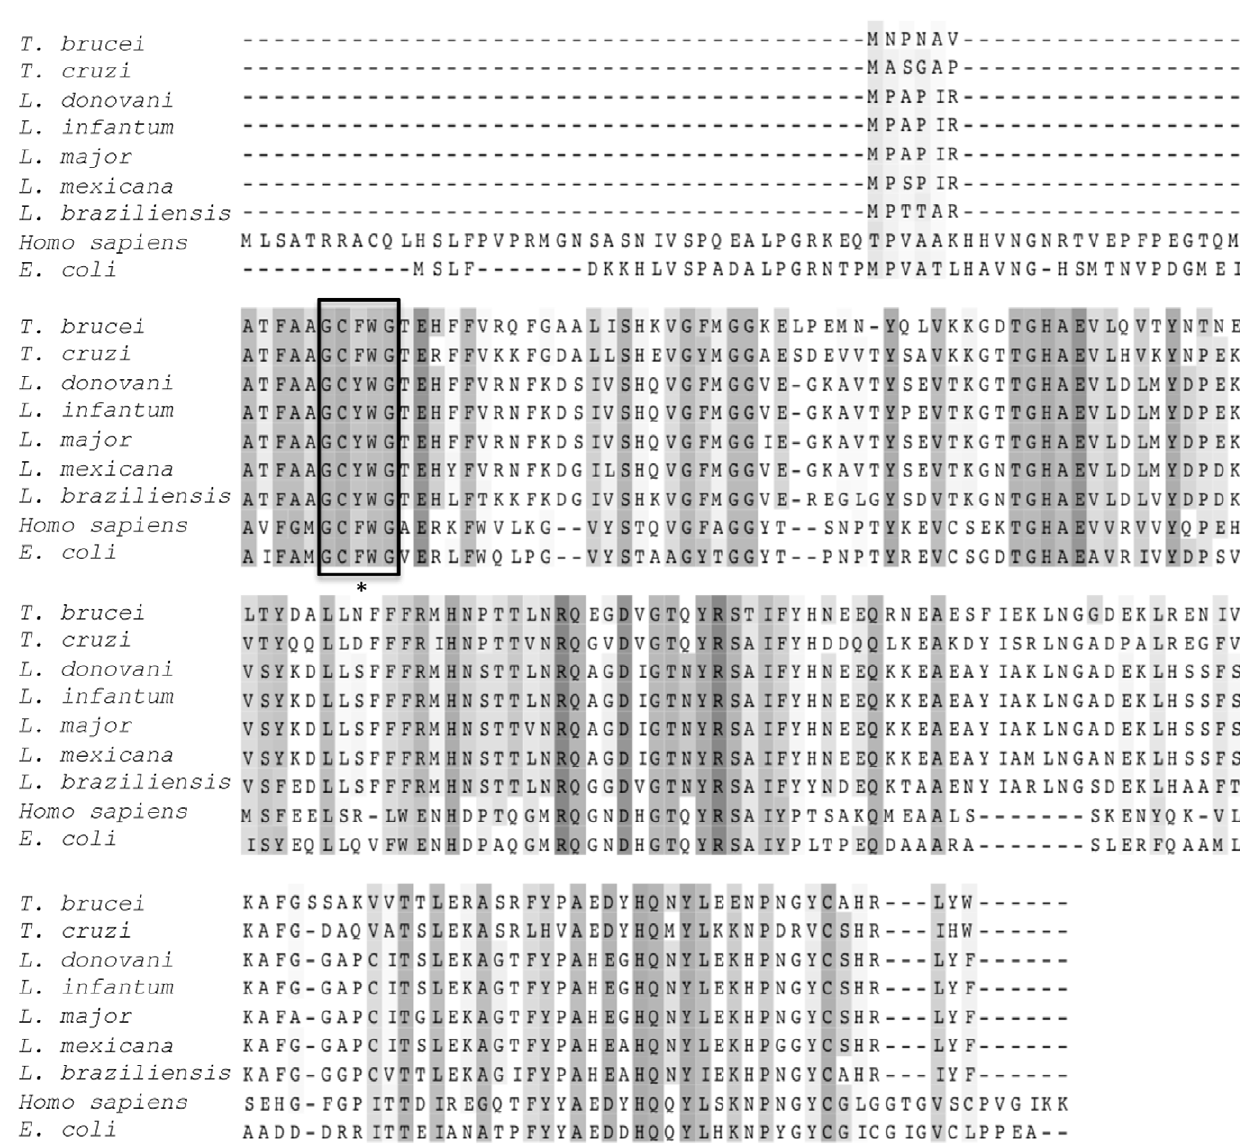
Figure 1. Sequence alignment of L. major MsrA with known and putative MsrA enzymes from other Leishmania species and Trypanosoma species, as well as human and E.coli MsrA. The catalytic site is boxed, and the non-conserved residue within the site marked by an *. The degree of amino acid conservation is indicated by shading intensity. Sequence alignment was performed using ClustalW [55,56] and the resulting alignment viewed and edited using JalView software [57]. The following sequence accession numbers were used: L. major XP_001681026.1, L. donovani CBZ31842.1, L. infantum XP_001463331.1, L. mexicana CBZ23737.1, L. braziliensis XP_001562615.1, T. brucei XP_846892.1, T. cruzi XP_814806.1, Homo sapiens AAG09689.1, E. coli